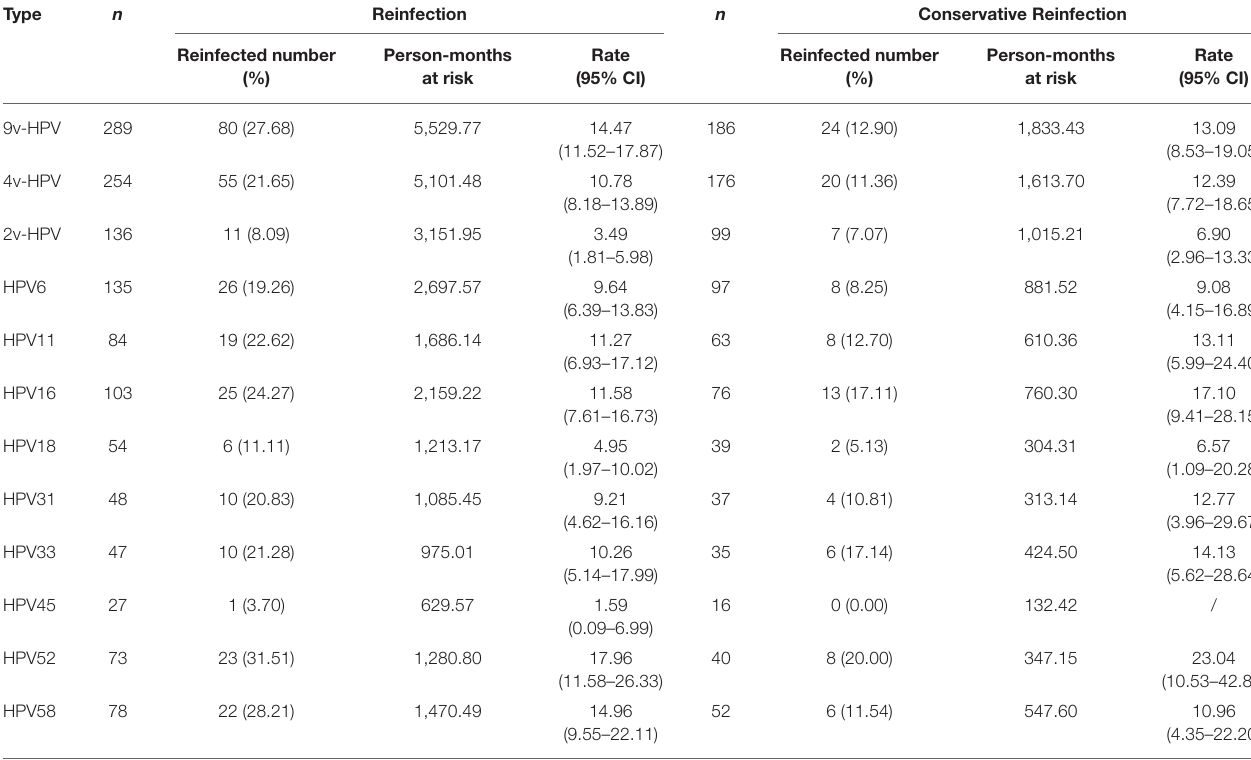
TABLE 4 | Incidence rates * of reinfection and conservative reinfection of specific HPV types among HIV-negative MSM ( N = 515).